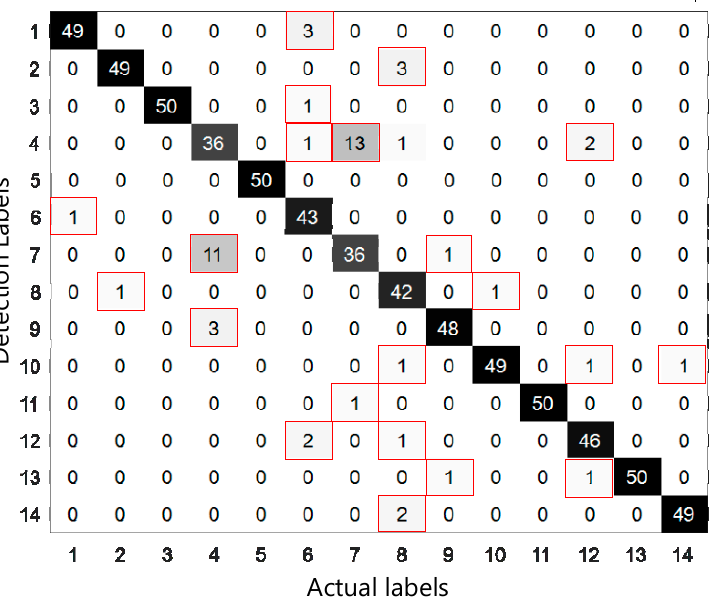
Figure 16. The confusion matrix of the test data (LSSVM).